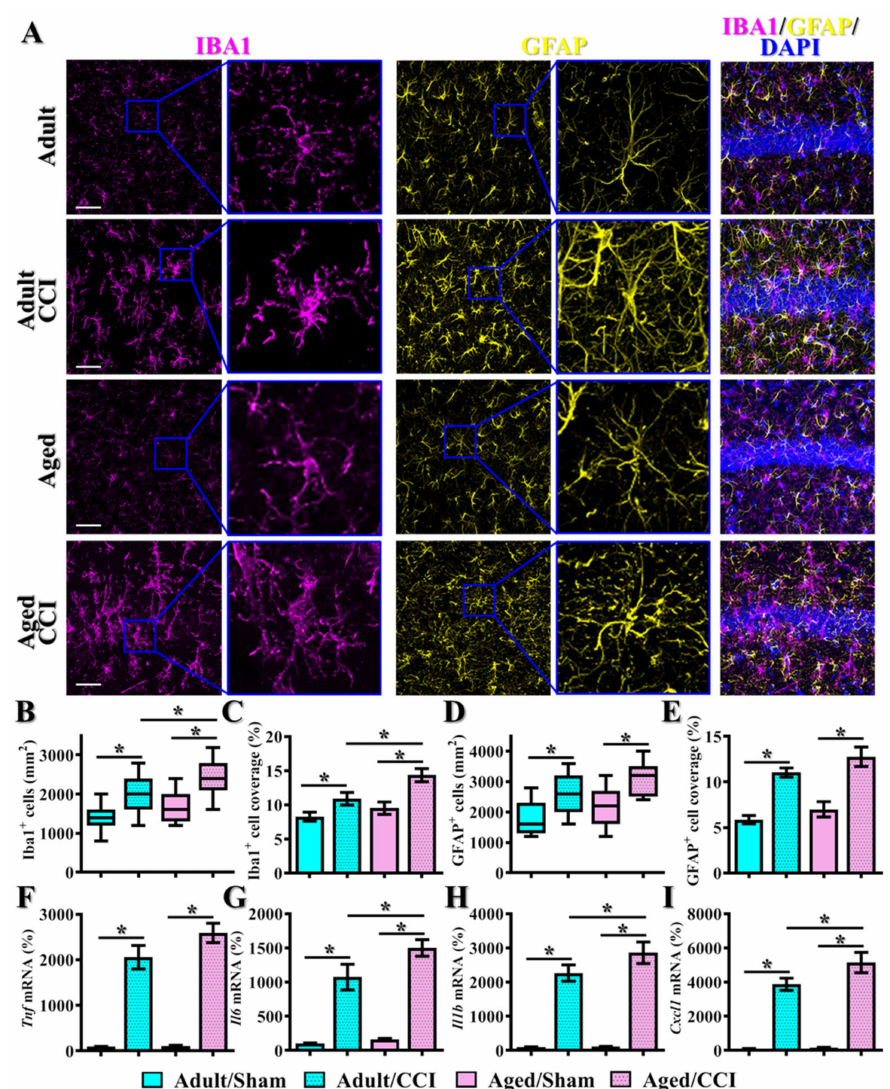
Figure 2. Increase in microgliosis and astrogliosis after CCI in the middle-aged animals. ( A ) Repre- sentative images of IBA1-positive microglial cells (color in magenta) and GFAP-positive astroglial cells (color in yellow) from different experimental groups. Blue, DAPI signal for the nuclear stain. Scale = 25 µ m; ( B , C ) Quantification of the regional density and percentage of area covered by IBA1 positive cells; ( D , E ) Quantification of the regional density and percentage of area covered by GFAP positive cells. n = 15 images from 5 mice in ( B – E ); ( F – I ) Quantification of the relative expression levels of Tnf , Il6, Il1b and Cxcl1 mRNAs from different experimental groups. n = 5 mice. All the data are presented as mean ± SEM and analyzed by a one-way ANOVA with Bonferroni’s post hoc analysis. * p <